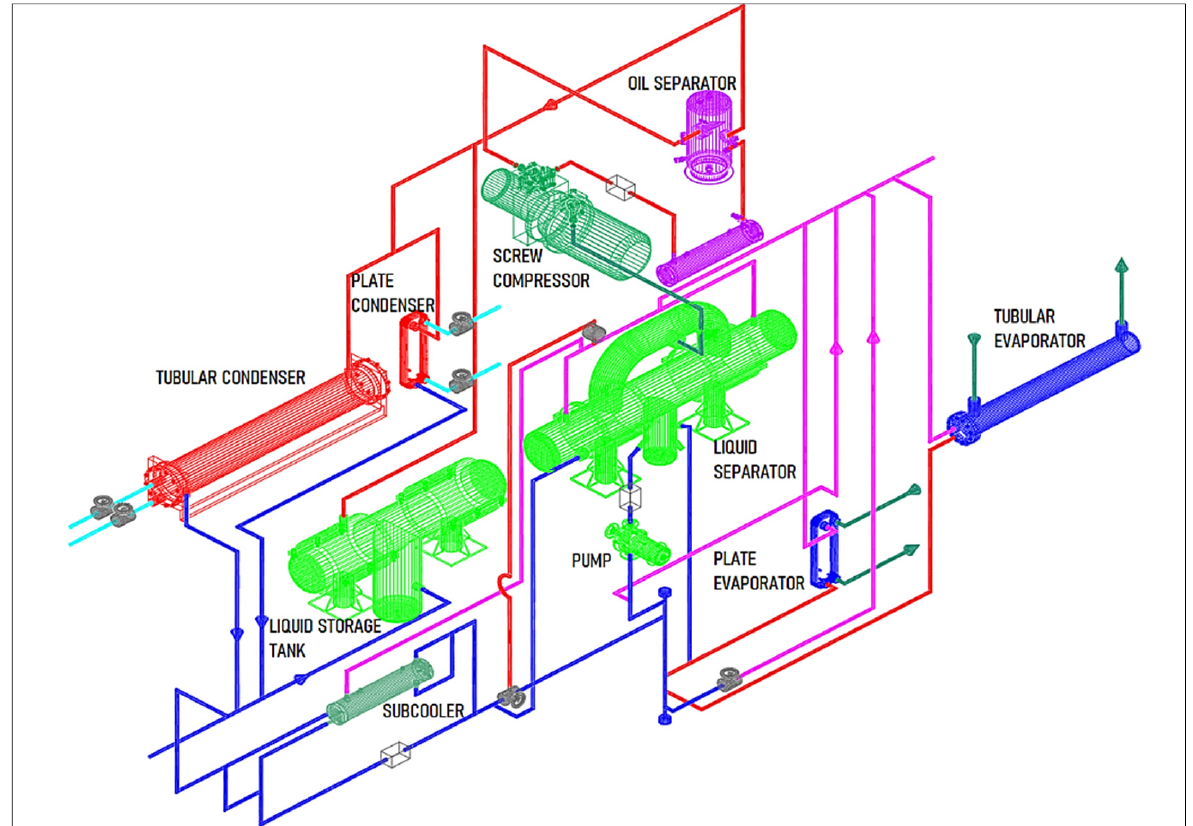
Figure 1. The experimental stand scheme. Source: own elaboration.